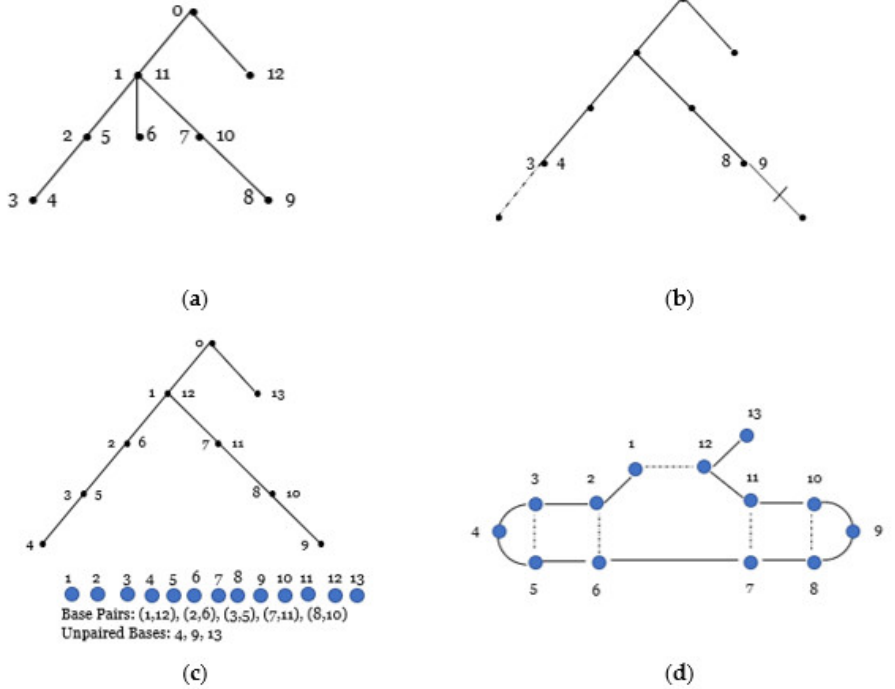
Figure 8. ( a ) τ 8,4,2 labeled linear tree. ( b ) By following the rules of the bijection, a new linear tree is formed by removing all labels, re-attaching the edge (1, 6) denoted by the dotted line to the end of old vertex (3, 4), and adding a new edge denoted by an edge with a tick mark to the end of old vertex (8, 9). ( c ) Follow the new labeling rules and number the vertices from one to thirteen and associate pairs and unpaired bases with a specific RNA structure. ( d ) RNA secondary structure S (13, 5). Dashed lines represent paired